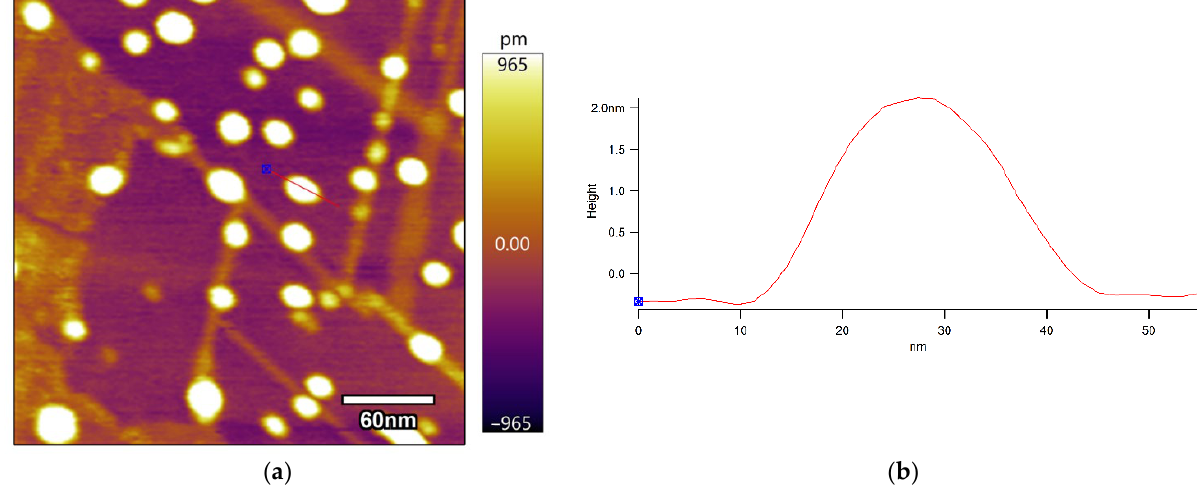
Figure 5. AFM image ( a ) of delaminated iron-based LDH and the height profile ( b ) of nanoparticles corresponding to the red line in the AFM image.